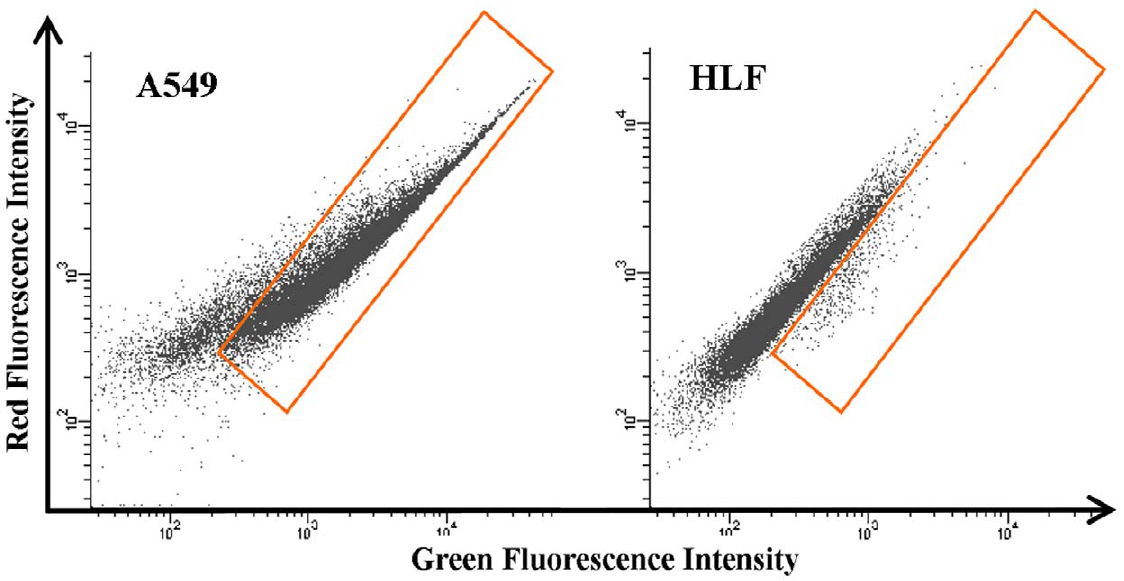
Figure 2. FACS results of selected monoclonal peptide-fluorescent bacteria binding with A549 cells and HLF cells. The binding fraction of A549 cells with bacteria (show in the orange gate) was 80% and that of HLF cells was 0.4%.